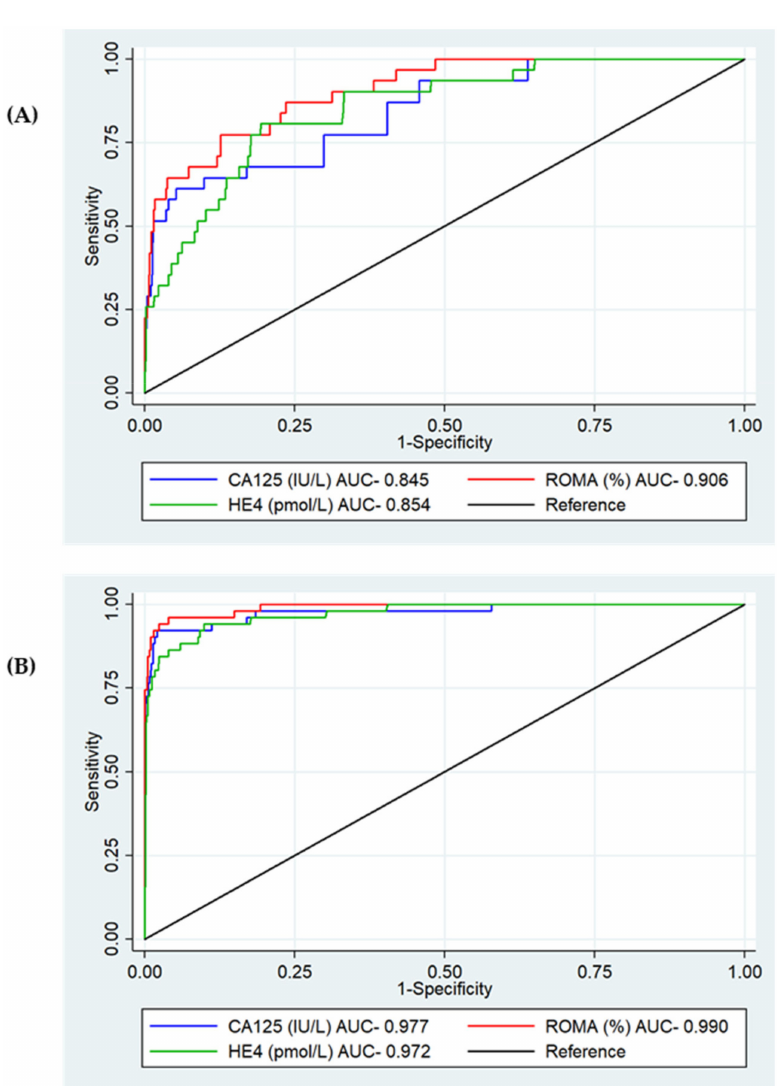
Figure 4. ROC analysis for serum CA125, HE4 and ROMA for the detection of epithelial ovarian cancer by stage at diagnosis. ( A ) Early stage. CA125 AUC 0.845 (95%CI 0.771–0.919), HE4 AUC 0.854 (95%CI 0.791–0.917), ROMA AUC 0.906 (95%CI 0.856–0.956), p < 0.001. ( B ) Late stage. CA125 AUC 0.977 (95%CI 0.953–1.000), HE4 AUC 0.972 (95%CI 0.951–0.993), ROMA AUC 0.990 (95%CI 0.981–1.000), p =